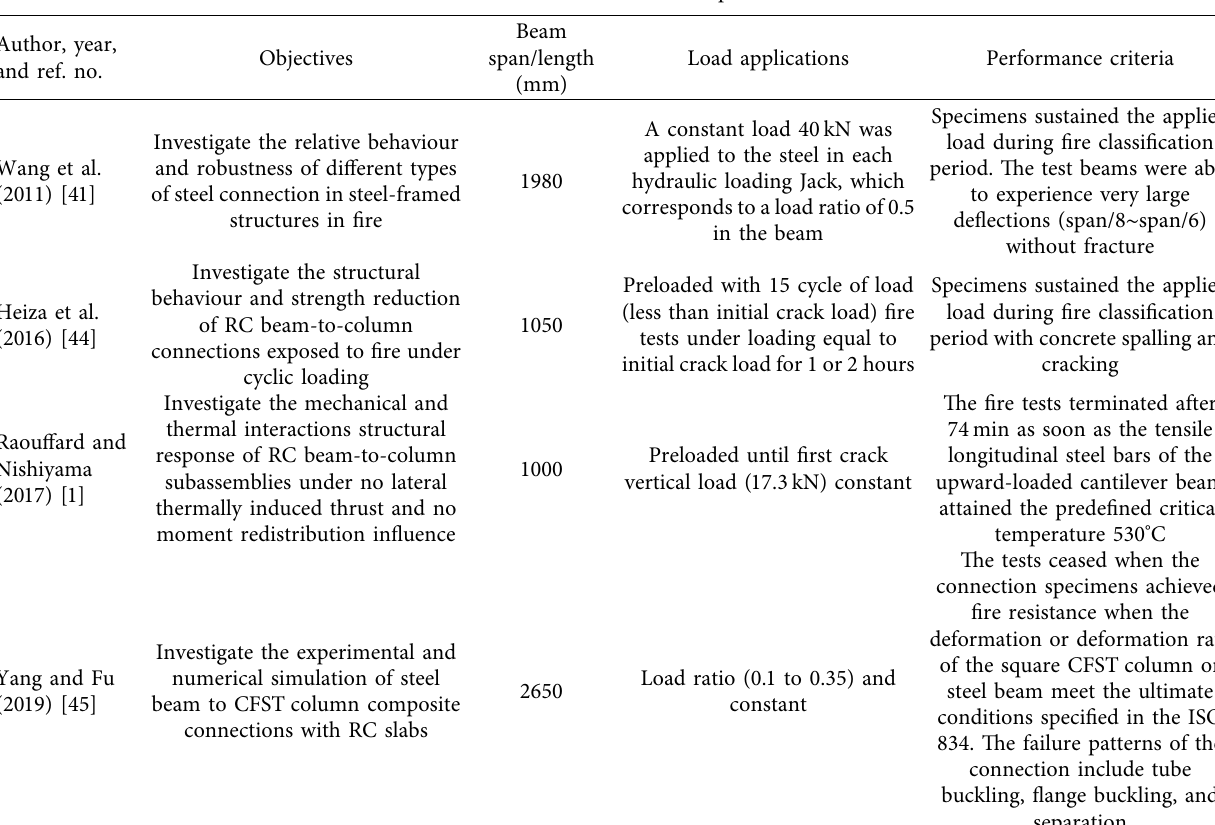
Table 2: Studies that terminated the fire tests at performance criteria